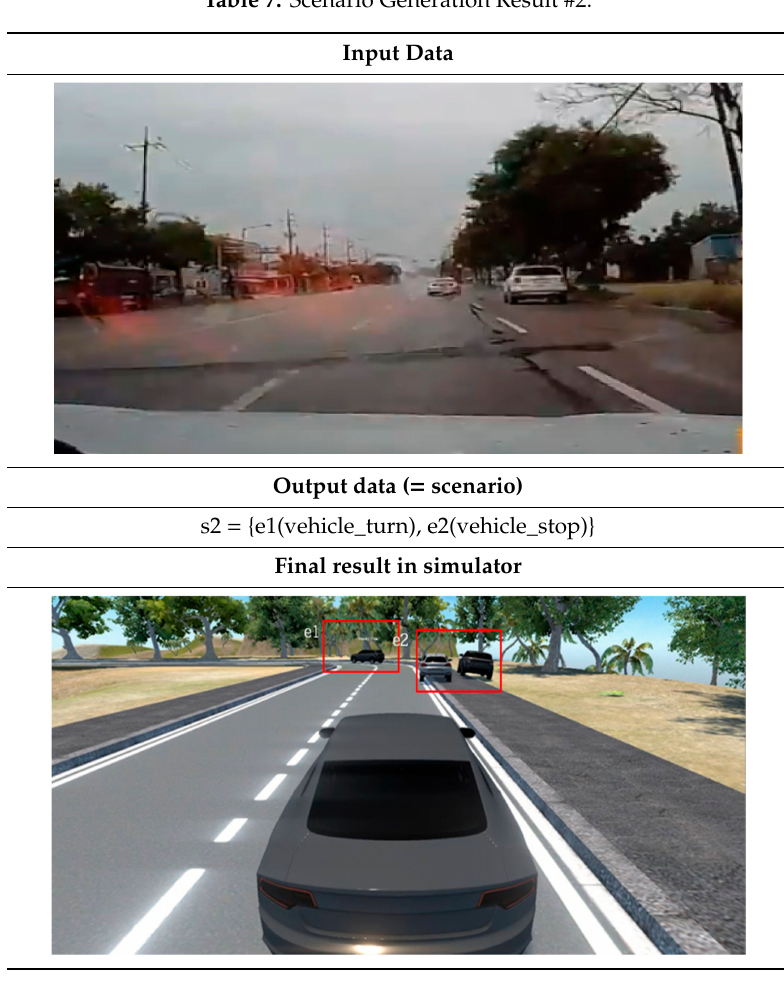
Table 7. Scenario Generation Result